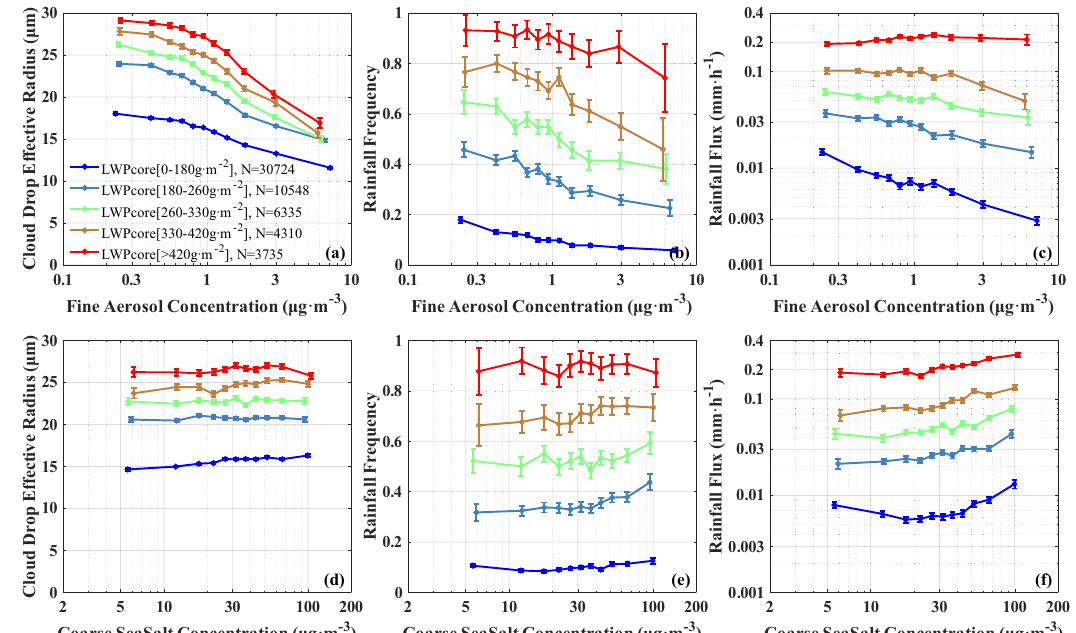
Fig. 2 Aerosol-driven cloud drop effective radius ( r e ) and rainfall variations for fi ne aerosol (top) and coarse sea spray aerosols (CSA) (bottom) concentrations at constant cloud liquid water path (LWP) bins. Shown are a r e , b rainfall frequency, and c fl ux variations (including both rainfall and non- rainfall cases) driven by fi ne aerosols. The d – f are the same as a – c , but for CSA. The color lines connect the dots, which are the averaged r e , rainfall frequency and fl ux at eleven bins of fi ne ( a – c ) and CSA ( d – f ) aerosol concentrations, respectively, including the 0 – 5%, 5 – 15%, 15 – 25%, 25 – 35%, 35 –